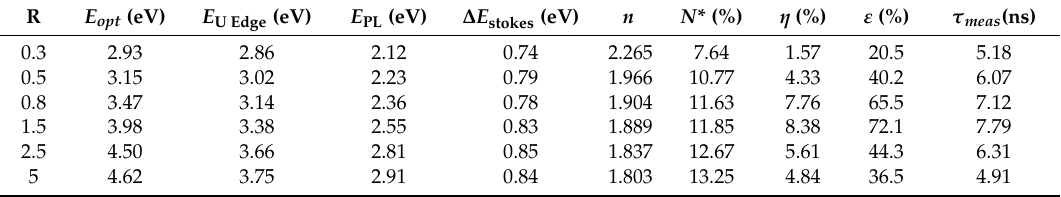
Table 1. The optical parameters, E PL ( E exc > E opt ), PL QEs, and ns-PL lifetimes of a-SiN x O y